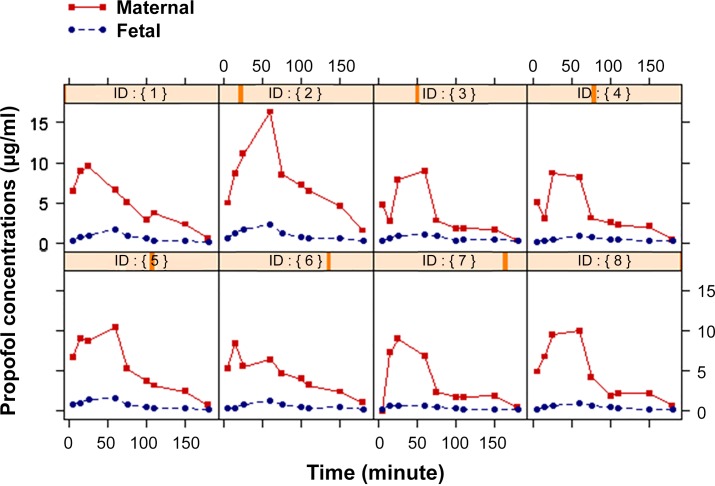
Propofol concentration time profiles for each fetal-maternal sheep unit (n = 8).Propofol was administered to the ewes as a bolus of 3 mg/kg, followed by an infusion of 450 μg/kg/min for 60 minutes. After that, propofol infusion rate was decreased to 75 μg/kg/min for 90 more minutes, and then stopped.